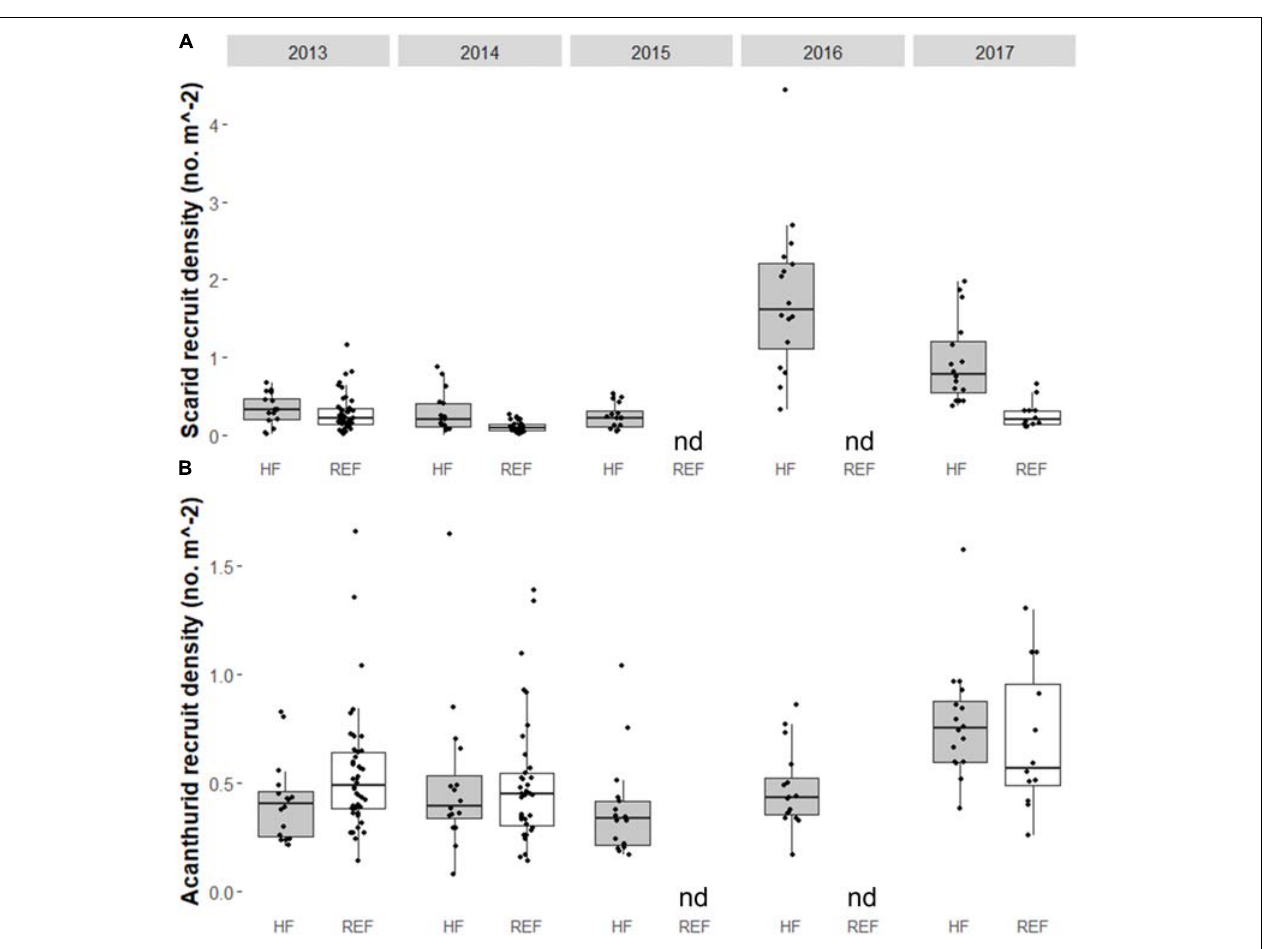
FIGURE 5 | Box and whiskers plot of the density of recruit (total length < 10 cm) (A) scarids and (B) acanthurids at the Hui Feng wreck site (shown in gray and noted on the x -axis with ‘HF’) and at reference sites (shown in white and noted on the x -axis with ‘REF’) on the reef terrace and backreef at Palmyra Atoll from 2013 to 2017. Note that y -axis varies between panels. Reference sites were not surveyed in 2015 or 2016 (no data indicated by ‘nd’). The wreck was removed between the 2013 and 2014 surveys.